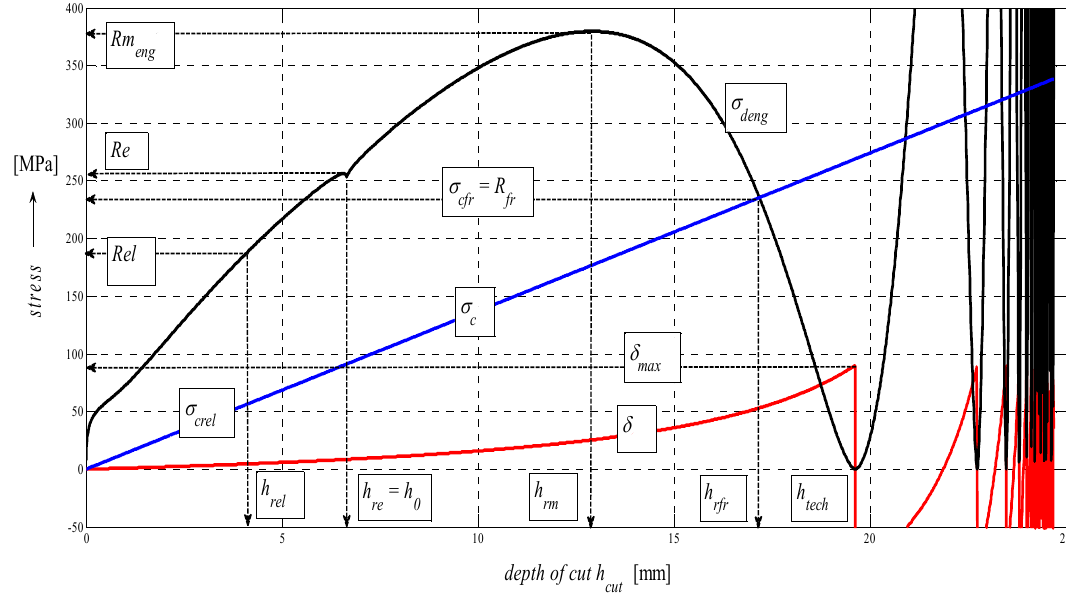
Figure 13. Diagram for AISI 1020 steel, dependence of functions on absolute depth.